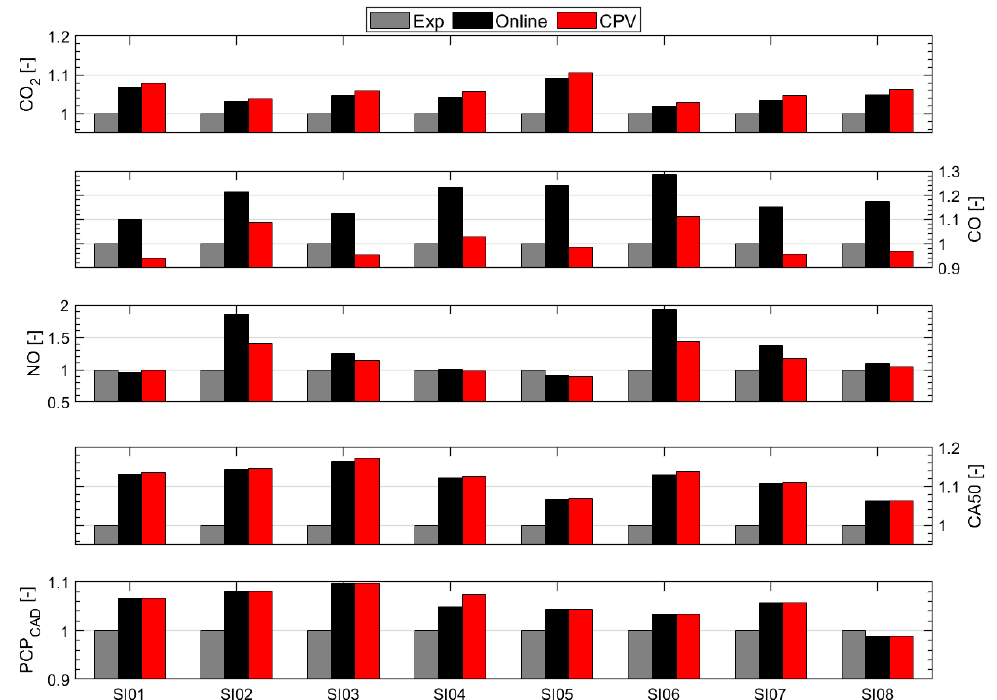
Figure 10. Experimental and simulated engine-out emissions as well as performance parameters (CA50 and PCP CAD location) for all operating conditions of the SI engine simulation campaign. Data have been normalized with respect to experimental